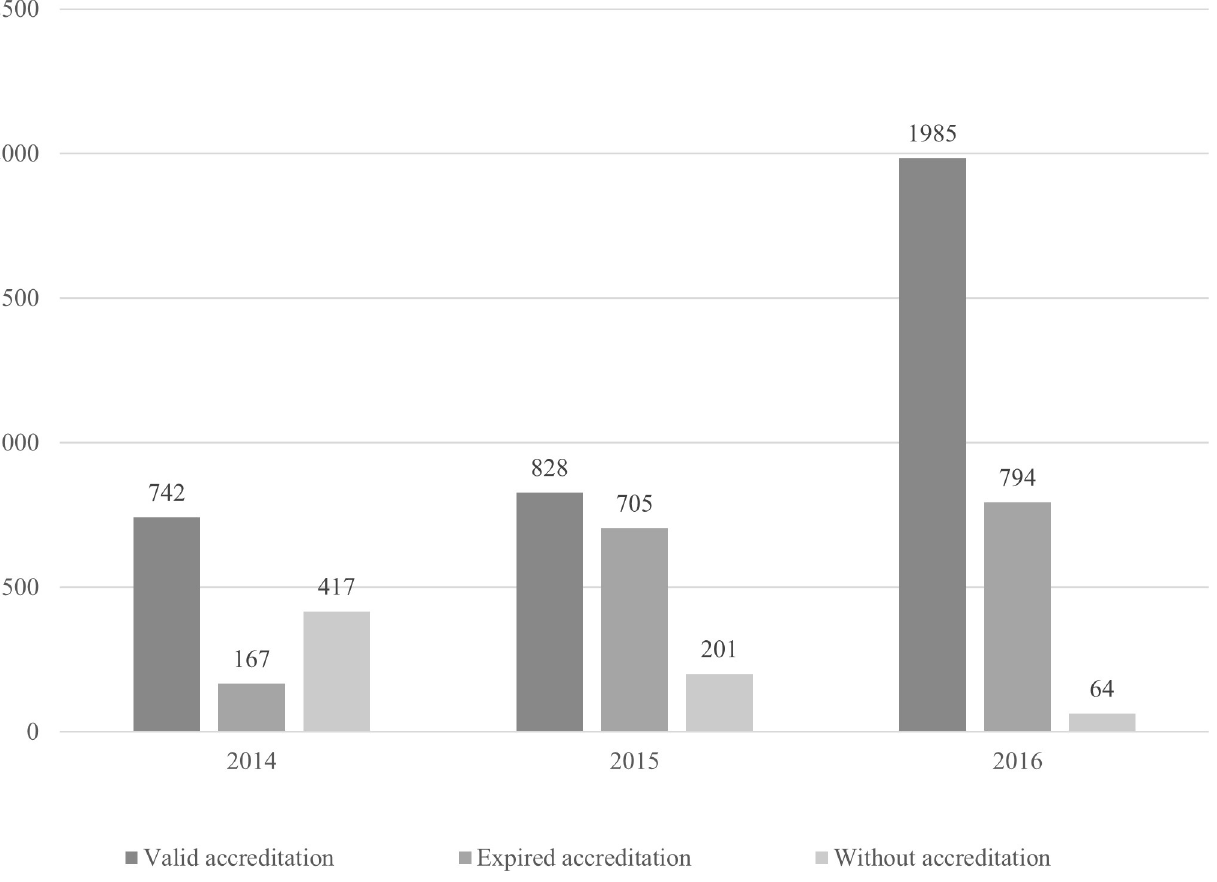
Fig 2. Number of public health centers dispensing thalidomide in Brazil between 2014 and 2016 [58]. https://doi.org/10.1371/journal.pntd.0008329.g002 Table 1. Clinical indications approved for use of thalidomide in